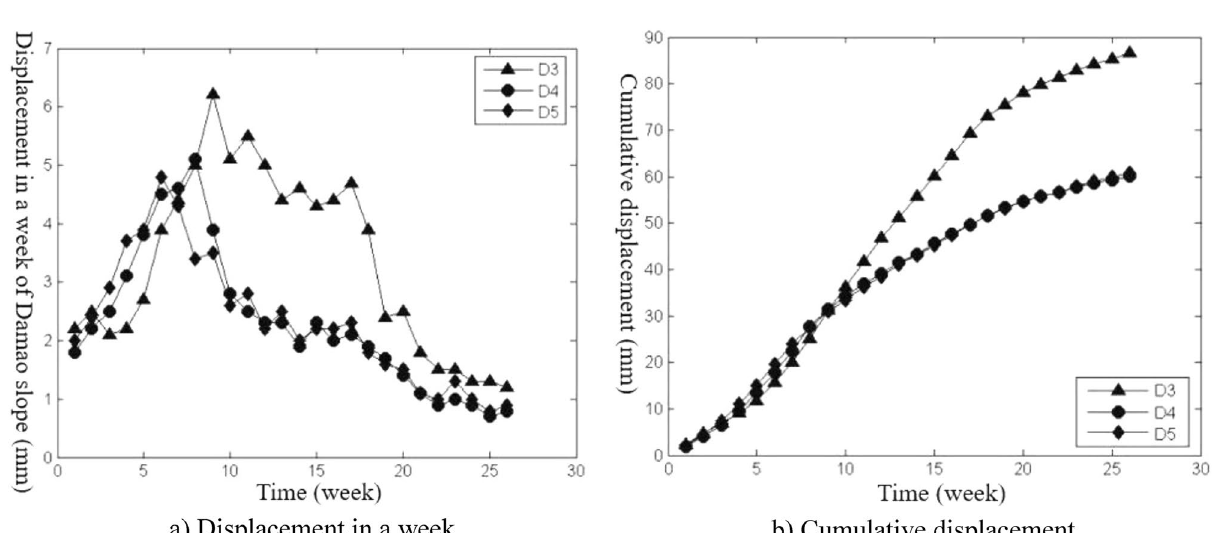
Figure 5. Displacement curves of third-level platform monitoring points from May 24 to November